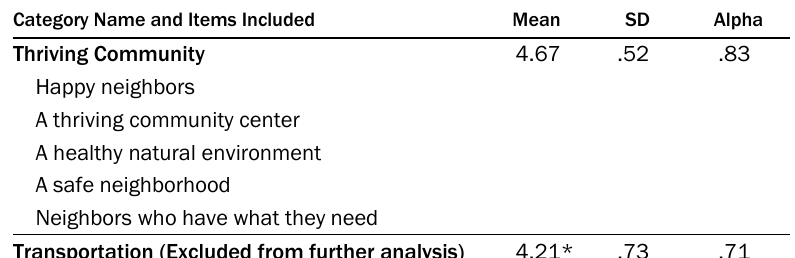
Table 4. Categories of Envisioned Future Community Features Category Name and Items